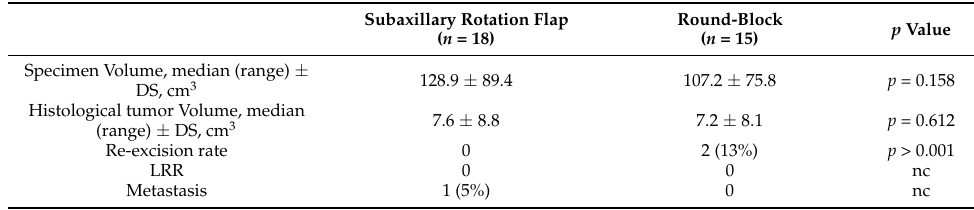
Table 2. Oncological and surgical outcomes.